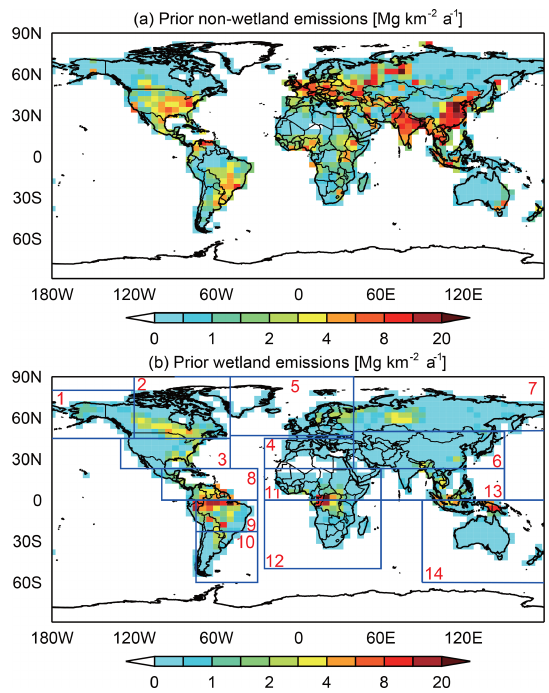
Figure 3. Prior estimates of mean 2010–2017 methane emissions. Panel (a) shows the non-wetland emissions on the 4 ◦ × 5 ◦ grid used for the inversion. Panel (b) shows the wetland emissions and the 14 subcontinental wetland regions used for the inversion following Bloom et al. (2017).